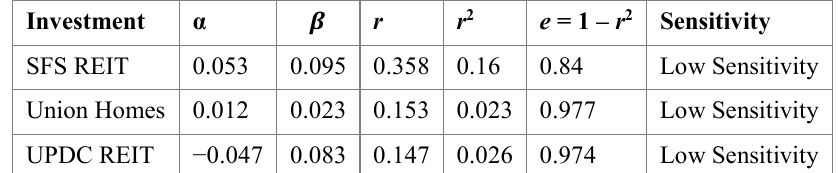
Table 3. Sensitivity of the Investment Returns to Growth in the Market Index Investment